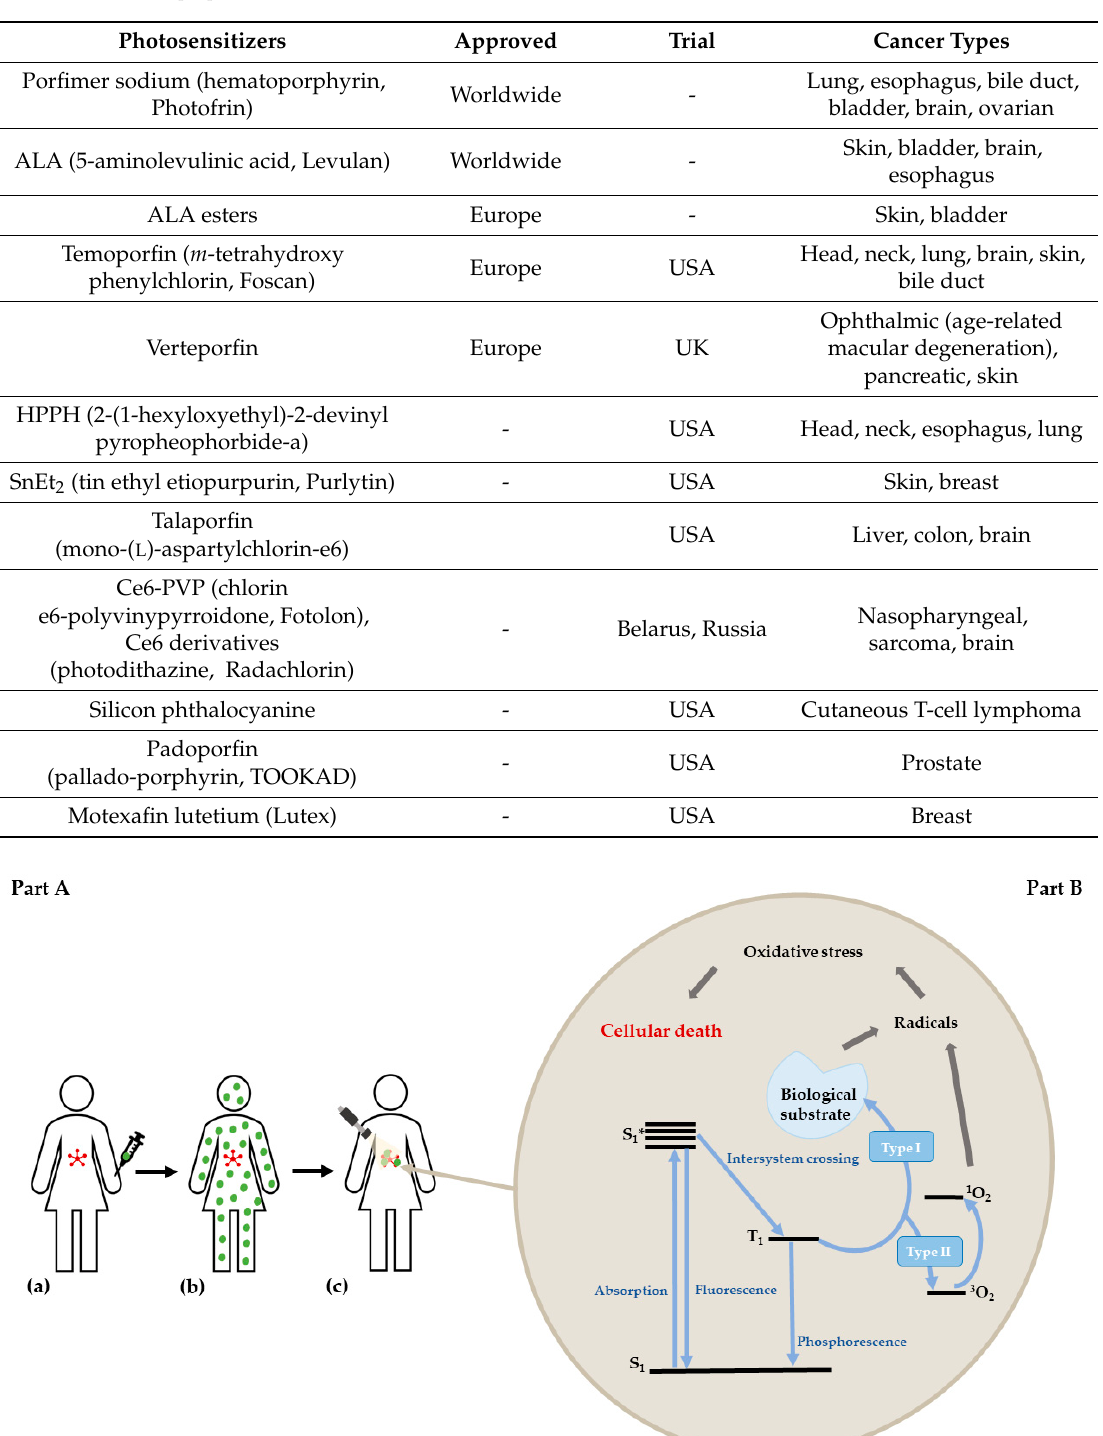
Table 1. List of photosensitizers approved by the FDA (Food and Drug Administration) or under clinical trials [14].